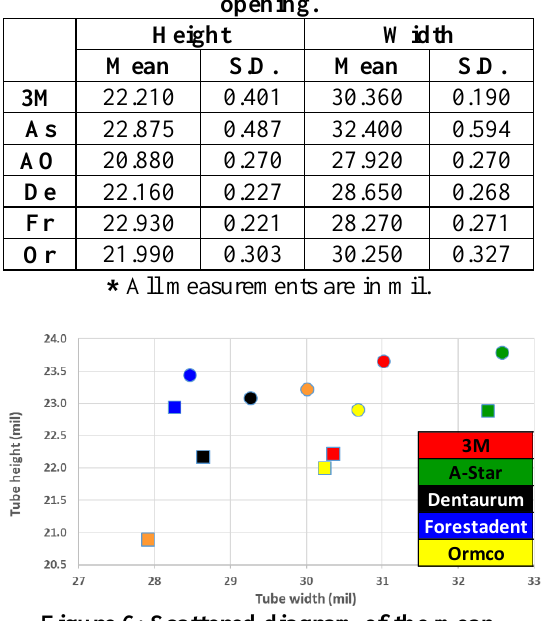
Figure 6: Scattered diagram of the mean height and width of the molar tube front (●) and back (■) openings. Table 3: The difference in the dimensions